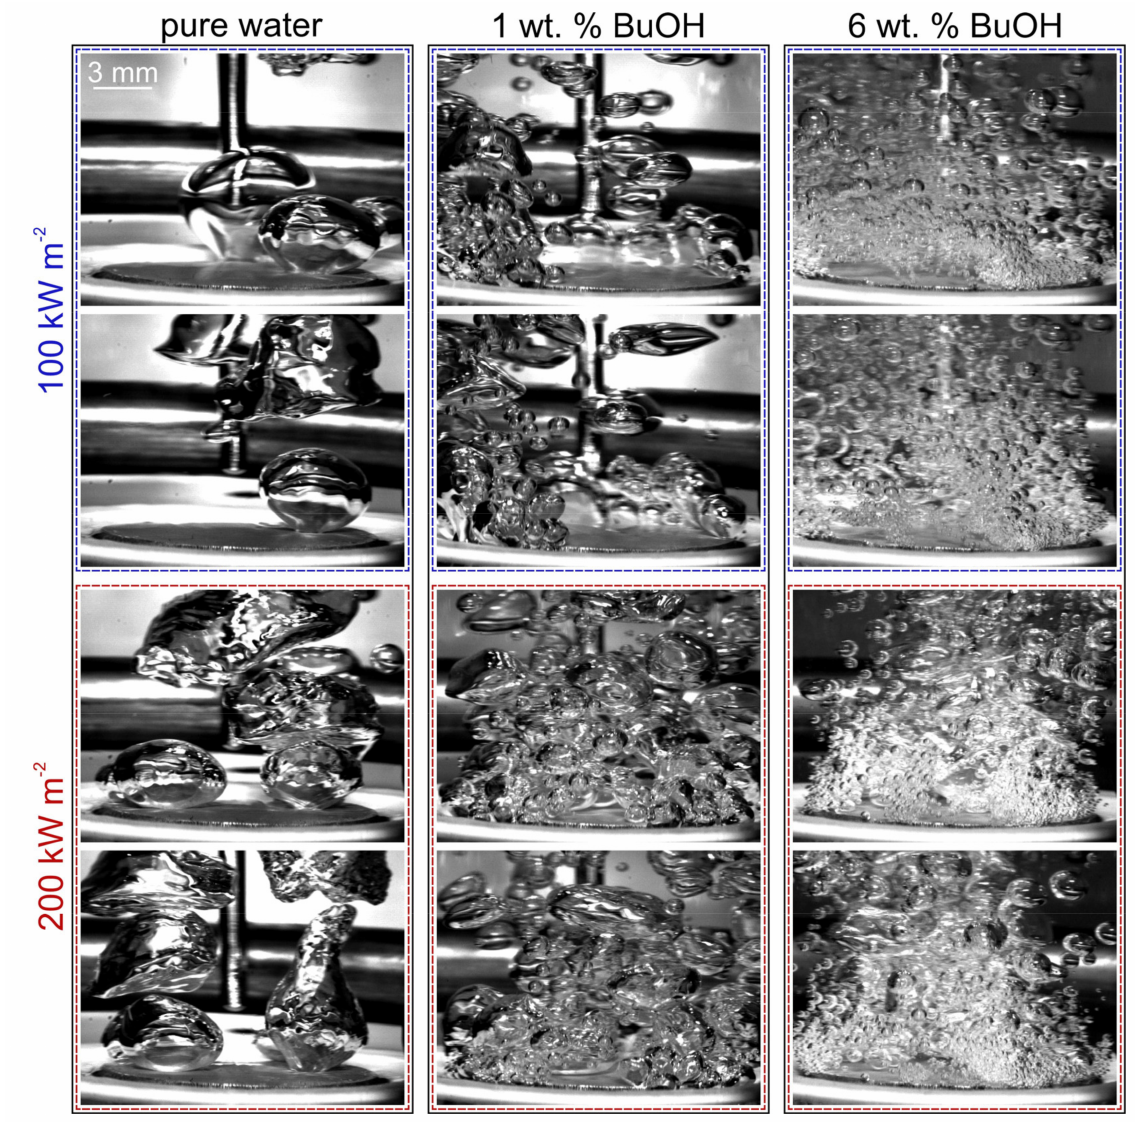
Figure 9. High speed snapshots of the boiling process on the untreated reference surface at two different heat fluxes during boiling of water ( left column ), 1 wt.% 1-butanol mixture ( middle column ) and 6 wt.% 1-butanol mixture ( right column